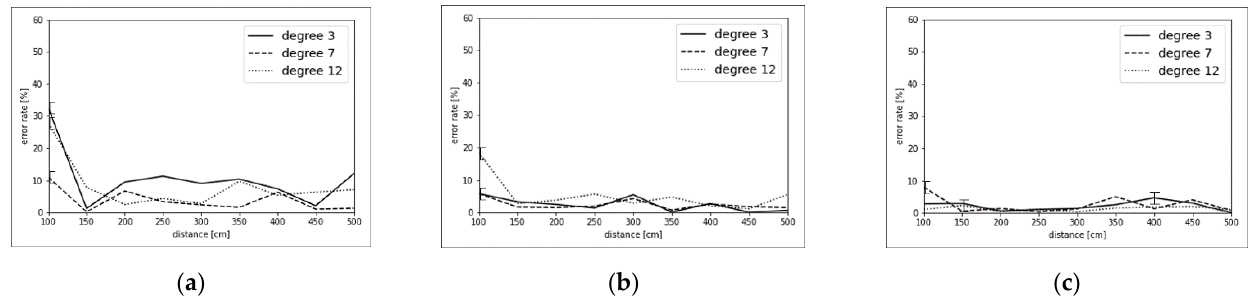
Figure 11. Test results with respect to various baselines and angles at a height of 50 cm: ( a ) error rates corresponding to various angles and a baseline of 10 cm, ( b ) error rates corresponding to various angles and a baseline of 20 cm, ( c ) error rates corresponding to various angles and a baseline of 30 cm.